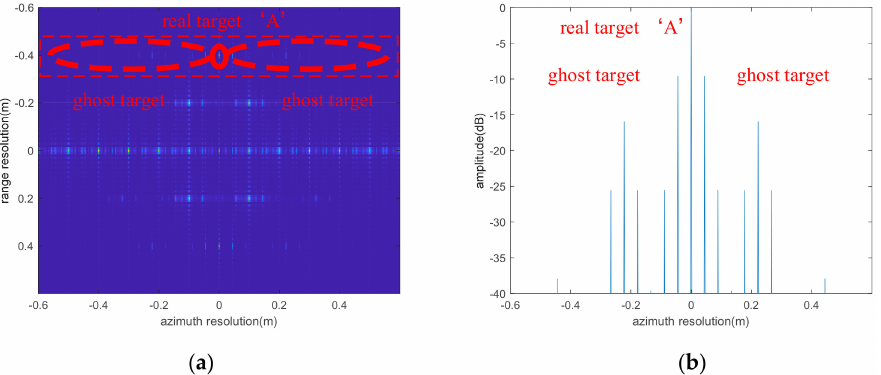
Figure 23. ( a ) The imaging result without compensation; ( b ) azimuth profile of targets in the red dashed boxes.